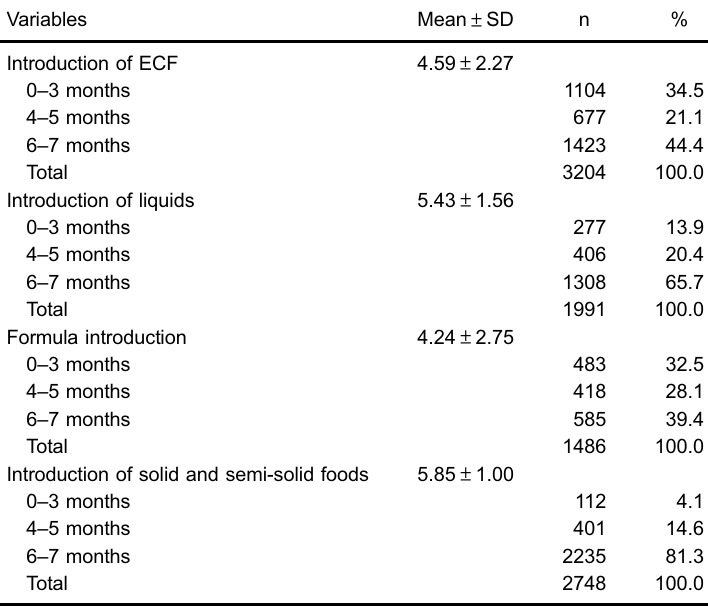
Table 2. Breastfeeding and feeding habits of babies from São Luis, MA cohort, Brazil, 2010 –